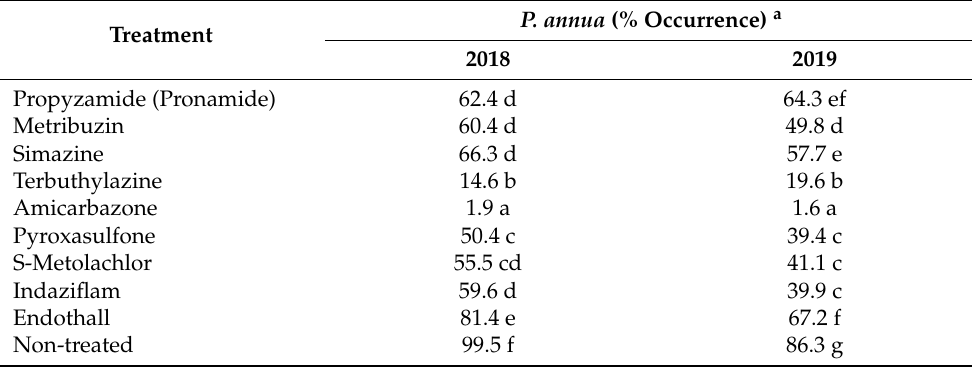
Table 5. Effect of spring herbicide treatments on % occurrence of P. annua in golf turf in 2018 and 2019 after 28 DAT.